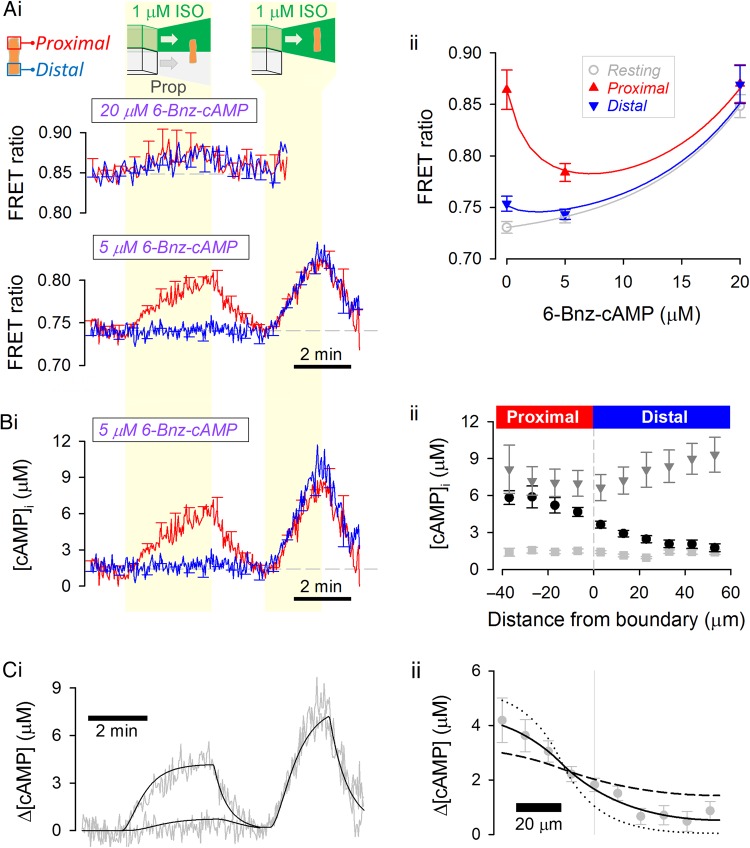
Cytoplasmic cAMP diffusivity is not affected by saturating cytoplasmic cAMP-binding sites with the analogue 6-Bnz-cAMP. (A) (i) Experiment similar to that shown in Figure 1B performed on myocyte AM-loaded with 20 µM (upper panel; n = 7/3; measured at half the normal acquisition frequency) or 5 µM (lower panel; n = 11/3) 6-Bnz-cAMP, a cAMP analogue with affinity for cAMP-binding sites. (ii) FRET ratio under resting conditions and at the proximal and distal end of the cell during dual microperfusion. The decreasing magnitude of FRET response to proximally presented ISO with higher doses of 6-Bnz-cAMP is due to a right shift in the [cAMP]-H187 calibration curve. (B) (i) [cAMP] time course in cells loaded with 5 µM 6-Bnz-cAMP. (ii) Longitudinal [cAMP] profiles, relative to boundary position, measured under resting conditions (light grey squares), during the last 10 s of dual microperfusion (black circles) and during the last 10 s of uniform exposure to agonist (dark grey triangles). (C) Model fit to (i) time course and (ii) longitudinal profile. Best-fit DcAMP = 29 ± 7.1 µm2/s is not different from measurements made in the absence of 6-Bnz-cAMP. To illustrate the goodness-of-fit data, longitudinal profiles were also simulated for a four-fold lower (dotted lines) and a four-fold higher (dashed lines) DcAMP.